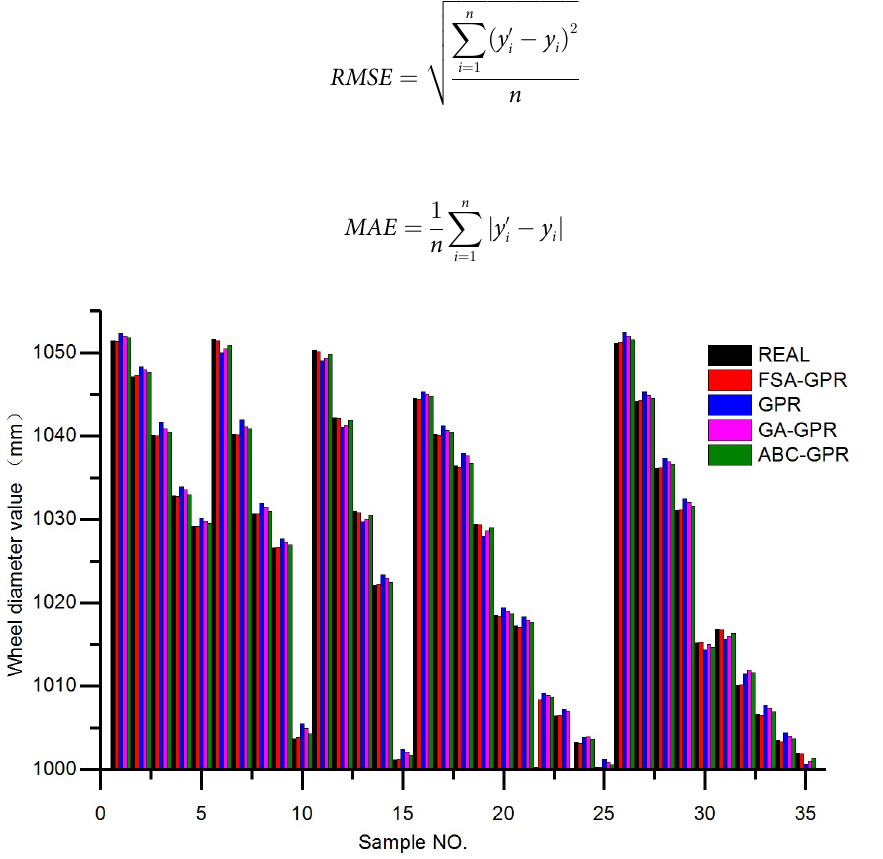
Fig 3. Comparison of wheel diameter value prediction results of four